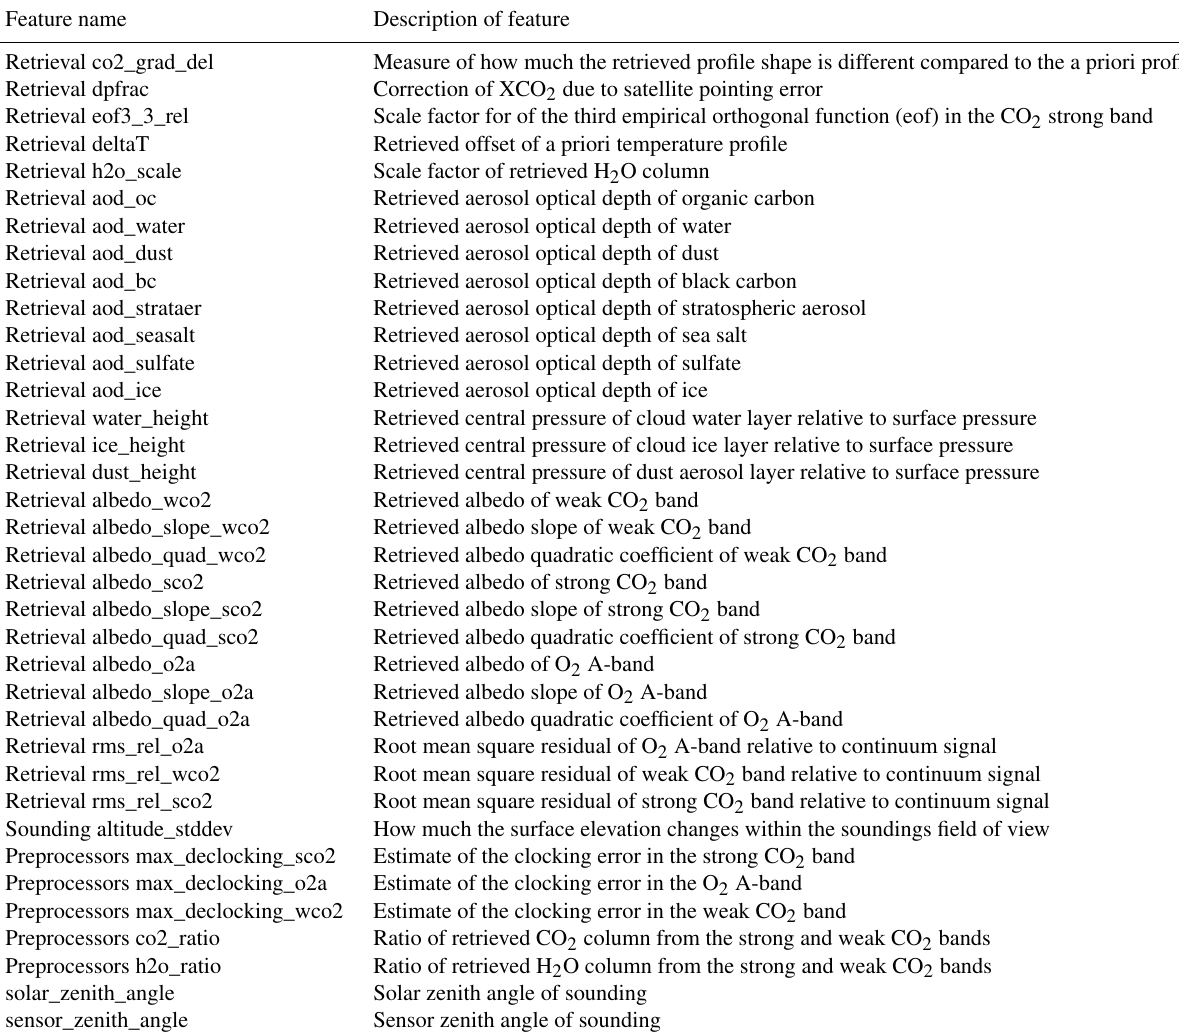
Table 1. List of all the features available to the input layer of the neural network and a brief description of the features based on the descriptions found in Osterman et al.